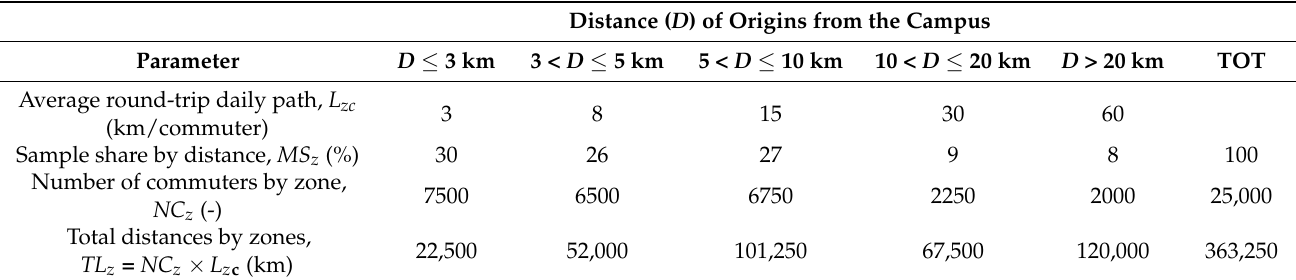
Table 1. Distribution of the commuter students by distances from the campus.